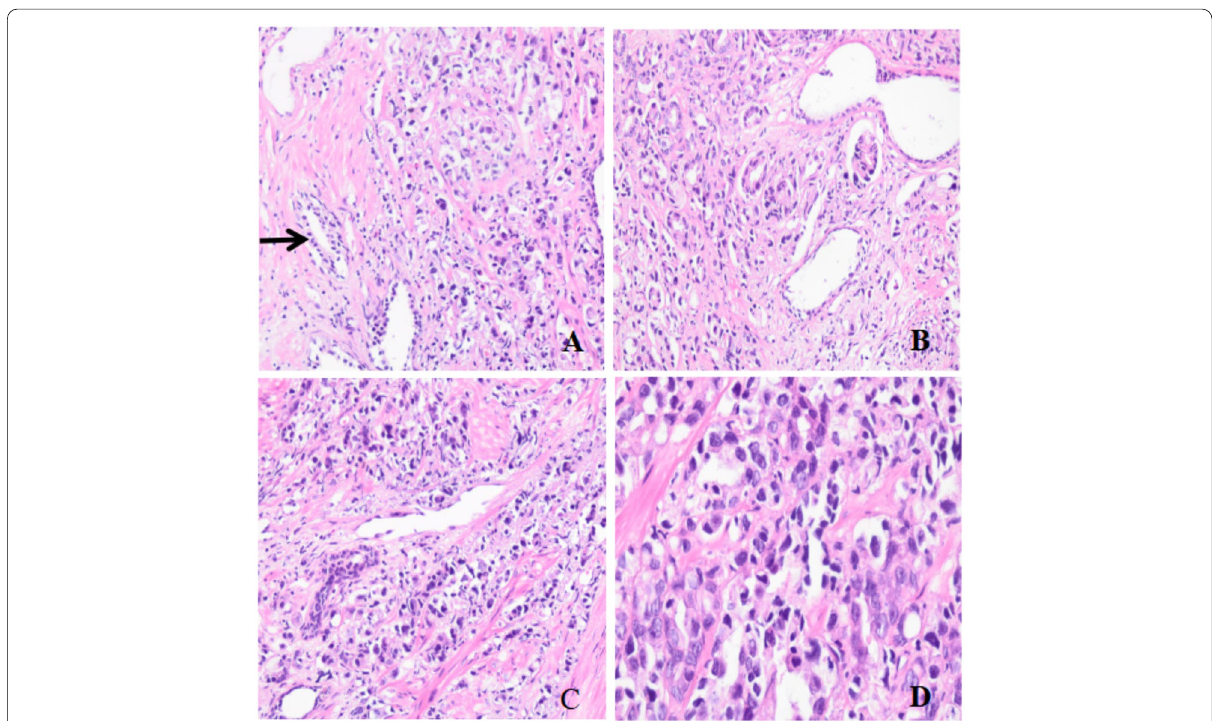
Fig. 1 Adenocarcinoma of the prostate, Gleason score9 (5 4), H&E. A Benign prostate tissue (black arrow head, magnification ✕ 200). B Poorly + formed glands (magnification ✕ 200). C Individual cells (magnification ✕ 200). D Atypical cells with prominent nucleoli (magnification ✕